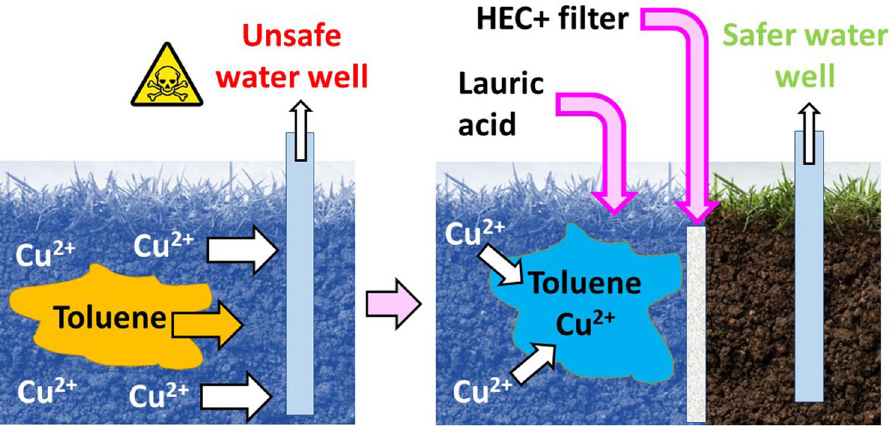
Figure 11. Schematics of the proposed approach, which combines HEC + injectable filters and lauric acid to simultaneously prevent copper ion and toluene migration. Once the flow of toluene and copper is arrested upstream of the filters, these contaminants can be extracted from the aquifer (e.g., using a pumping well). Note that while HEC + filters retain toluene in which Cu 2+ partitions, they allow water flow. Also note that while mixing lauric acid in canola oil is required to enable its injection in polluted aquifers, lauric acid can be introduced in wastewater to be treated at the surface in its dry form (e.g., as a powder).